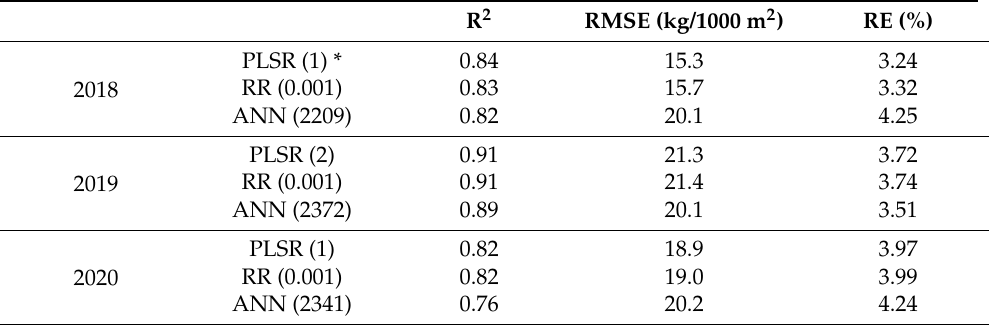
Table 4. Performance of partial least squares regression (PLSR), ridge regression (RR), and artificial neural network (ANN) models in the prediction of rice yield in single- and multi-year